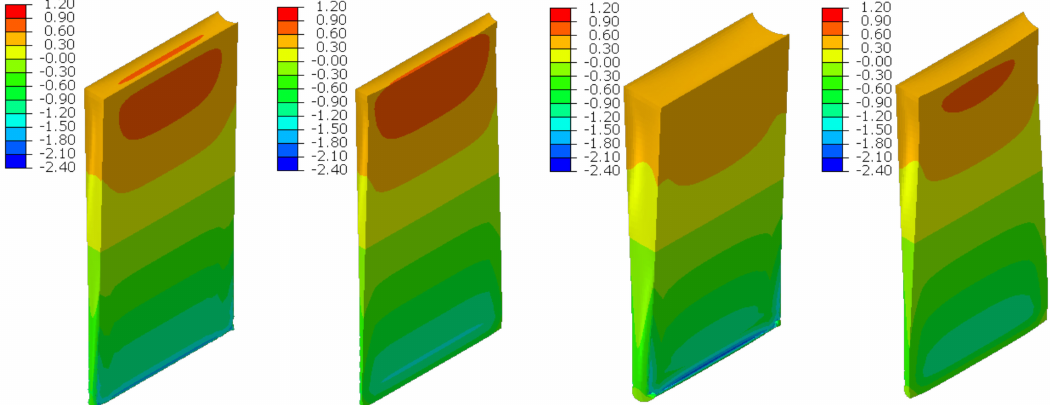
Figure 8. Deformations for scaling factor 1.0 and Cauchy stresses σ z in MPa for final load level. The width of the gap is equal to 1.0 cm, left graphics, and 2.0 cm, right graphics. Views on connection, first and third columns, or central plane, second and fourth